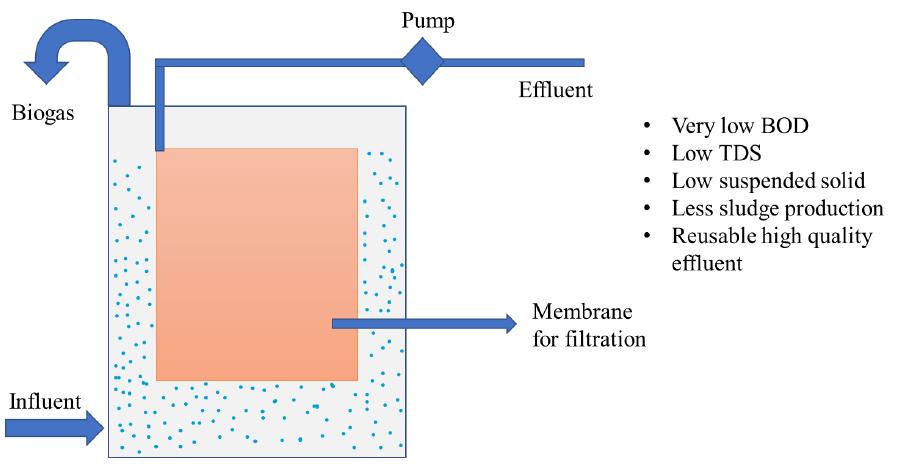
Figure 5. Schematic representation of anaerobic membrane bioreactor (AnMBR) technology.